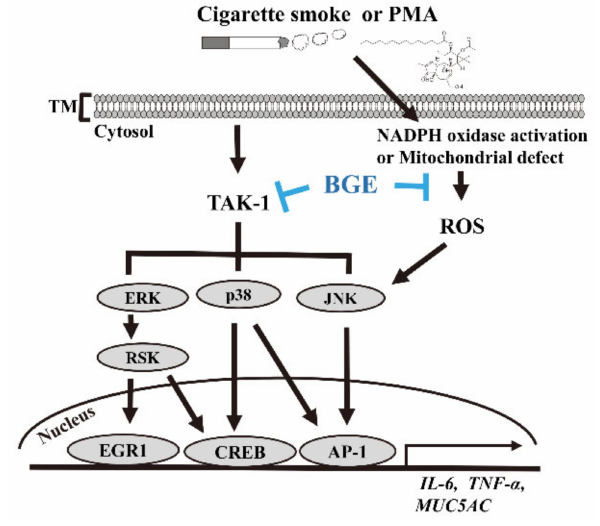
Figure 6. The anti-inflammatory mechanism of BGE in both lung airway epithelial cells and the CS/LPS-treated mice model. CS or PMA activates TAK1 and its downstream molecule MAPK signaling. This phosphorylation of MAPKs eventually results in a series of inflammatory reactions in lung epithelial cells and in the CS/LPS-treated mice model. BGE suppresses the expression of inflammatory cytokines, such as TNF- α , IL-6 and MUC5AC (the major form of secreted gel-forming mucin in vivo), both in vivo and in vitro. BGE directly binds to TAK1, inhibiting its activity. BGE exerts its anti-inflammatory effect by inhibiting the phosphorylation/activation of three MAPKs by directly suppressing TAK1 activity, leading to inactivation of inflammatory transcription factors, such as EGR1, CREB and